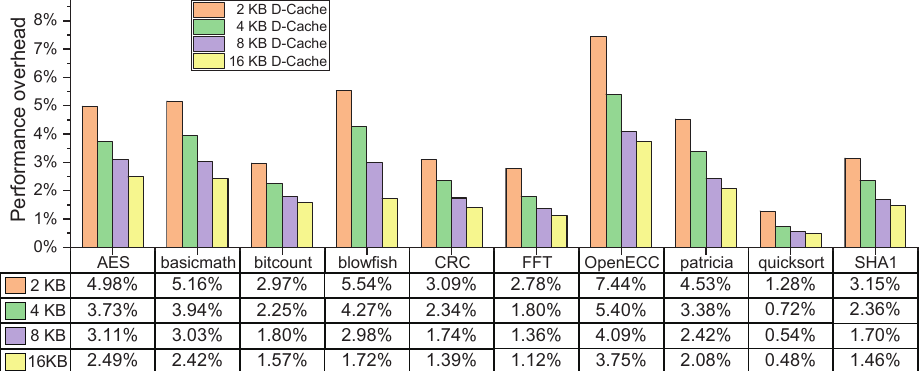
Figure 11. The performance overheads of the selected benchmarks under different sizes of